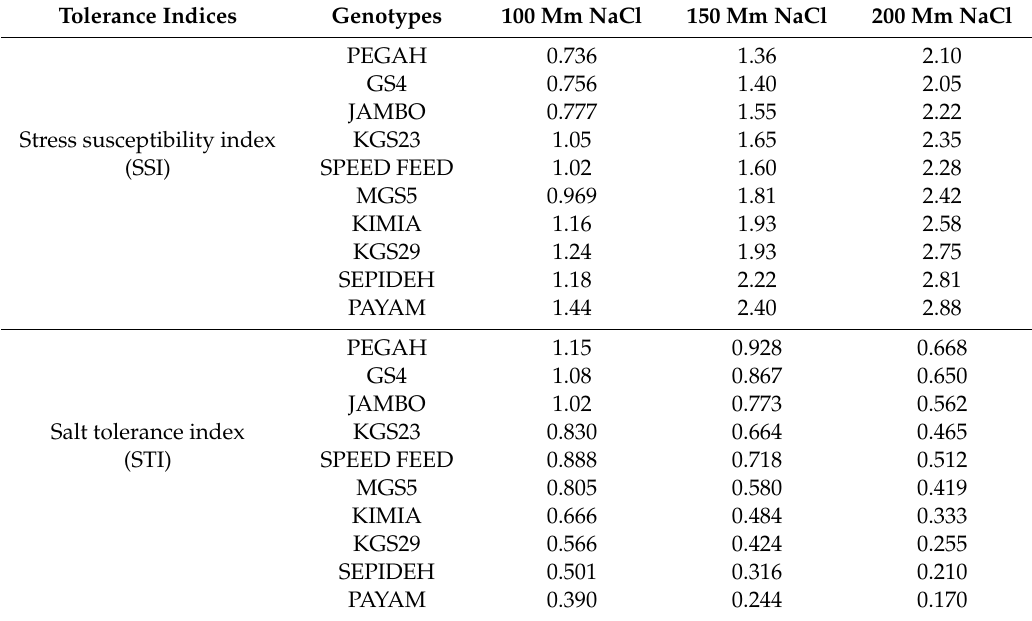
Table 4. Tolerance indices of ten sorghum genotypes in four salt